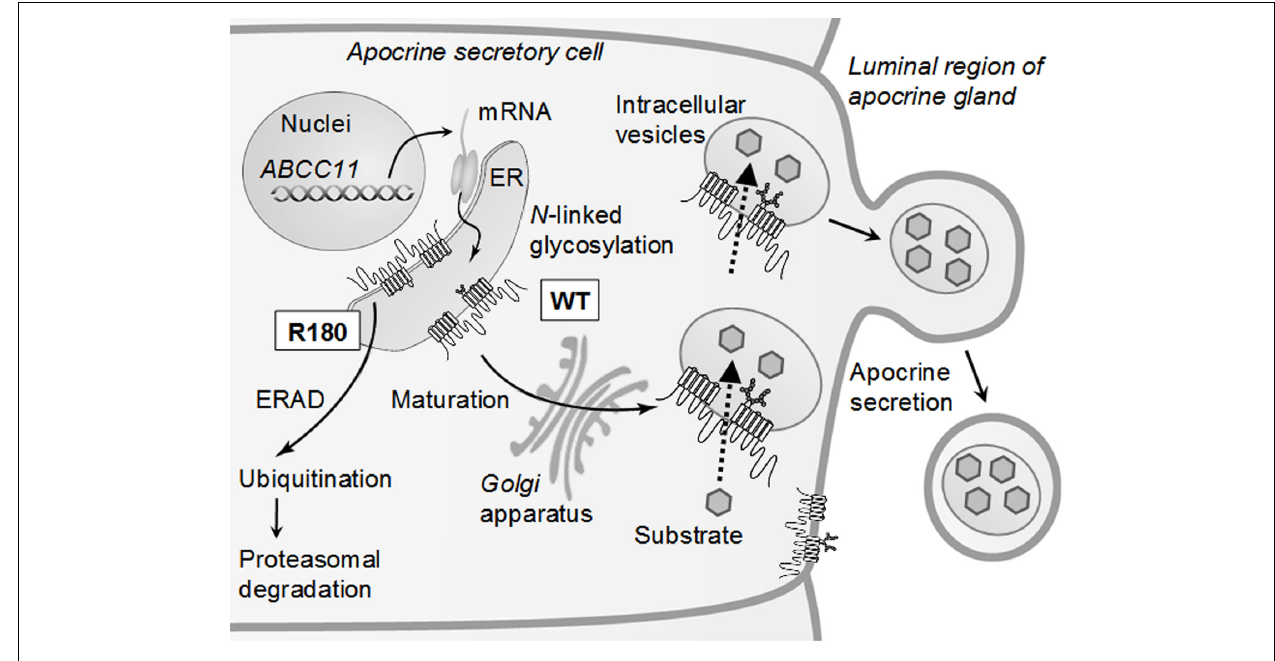
FIGURE 4 | Schematic illustration of intracellular sorting ofABCC11 WT and proteasomal degradation of the R180 (Arg180) variant in secretory cells of the apocrine gland. De novo synthesized ABCC11WT is N -linked glycosylated at Asn838 and Asn844 in the ER, further processed in the Golgi apparatus, and destined for the membranes of intracellular granules and vacuoles. Ceruminous components are thought to be transported by